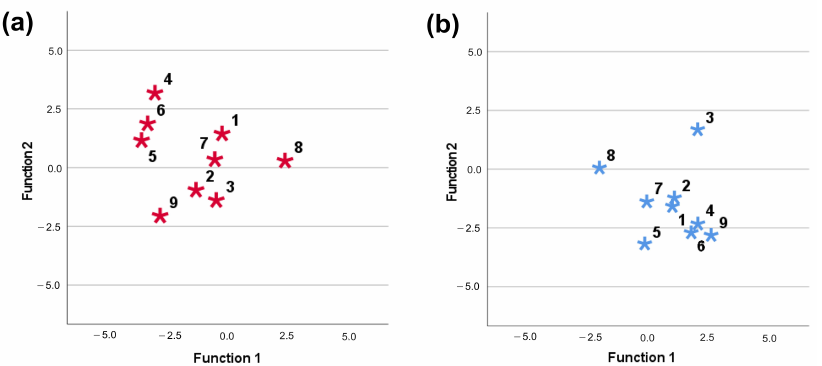
Figure 5. Sca(cid:308)erplots of the CVA of head and pronotum shapes, and body size together. The sexes were examined separately: ( a ) female and ( b ) male plots. The numbers in each plot correspond to the following Platynus species: 1 = P. complanatus ; 2 = depressus ; 3 = erythrocephalus ; 4 = maritimus n. sp. ; 5 = occitanus n. sp. ; 6 = peirolerii ; 7 = simonisi n. sp. ; 8 = teriolensis ; 9 = vignai n. sp. Red star = centroid of female data, blue stars =centroid of male data.